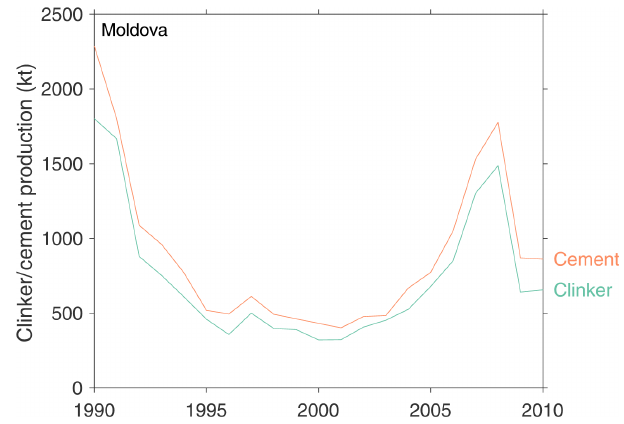
Figure D26. Clinker and cement production in Moldova (Ministry of Environment, 2013).